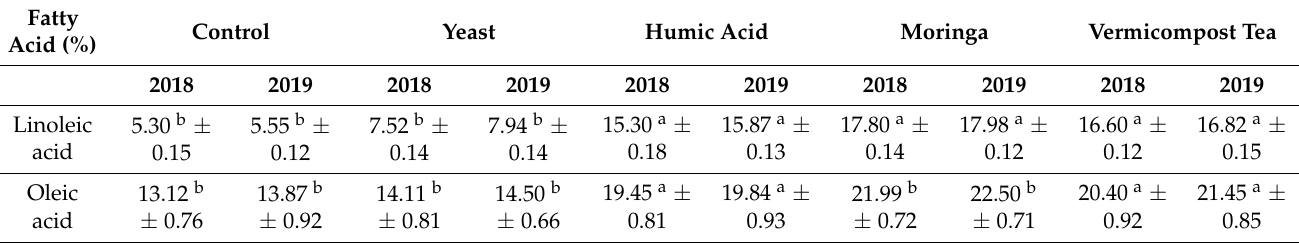
Table 11. Effect of biostimulants on fatty acid composition (%) of snap bean pods in growing seasons of 2018 and 2019.